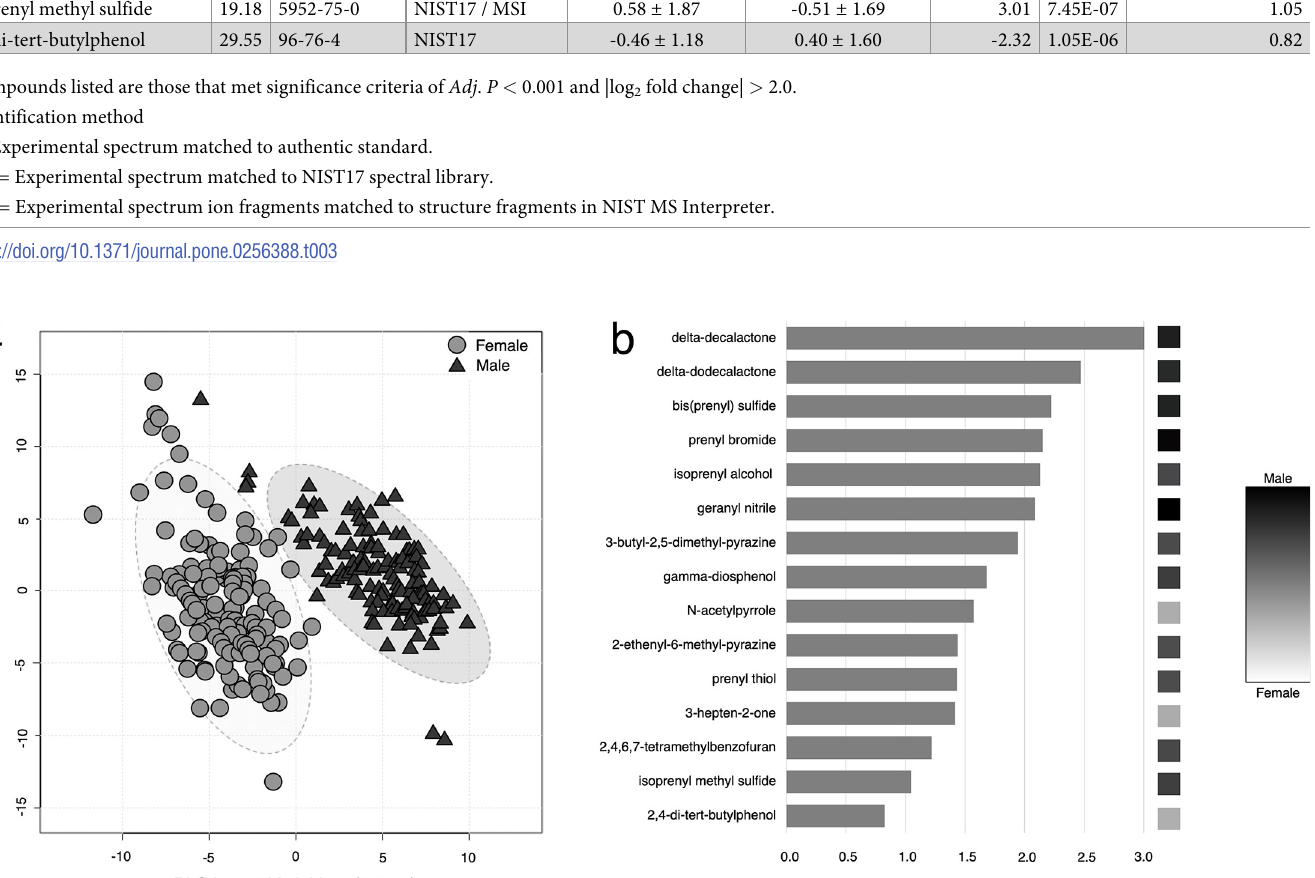
PLOS ONE | https://doi.org/10.1371/journal.pone.0256388 August 20,